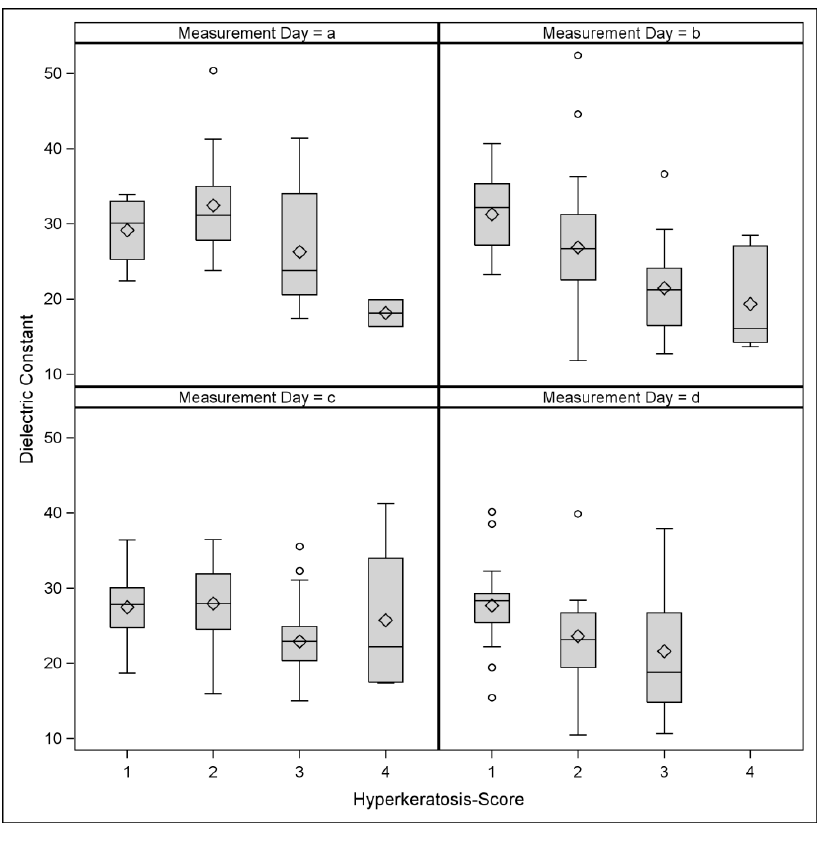
Figure 3. Distribution of the dielectric constant values across the four hyperkeratosis scores on each measurement day.